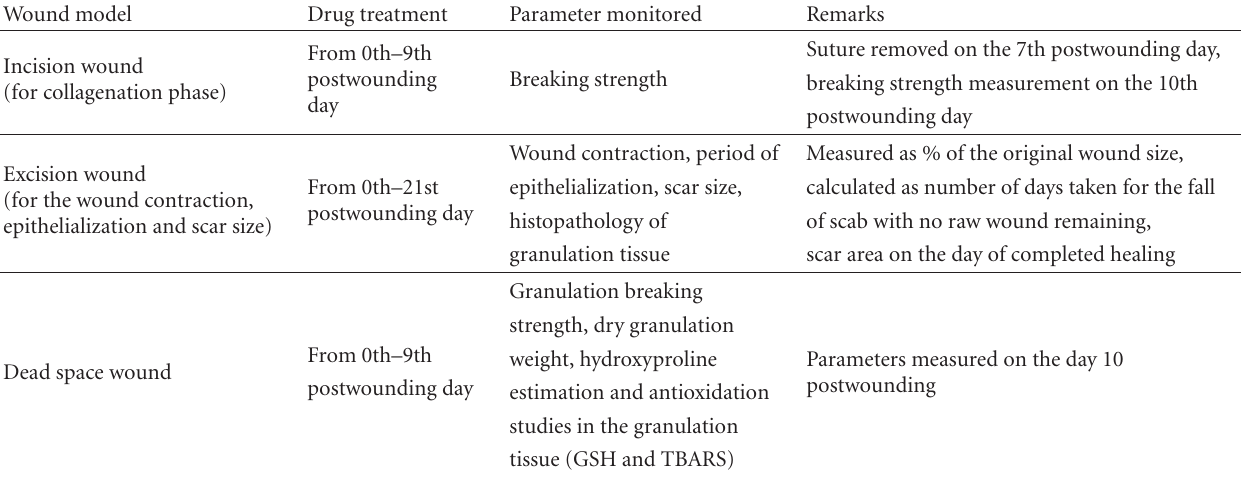
Table 1: Wound models employed and parameters